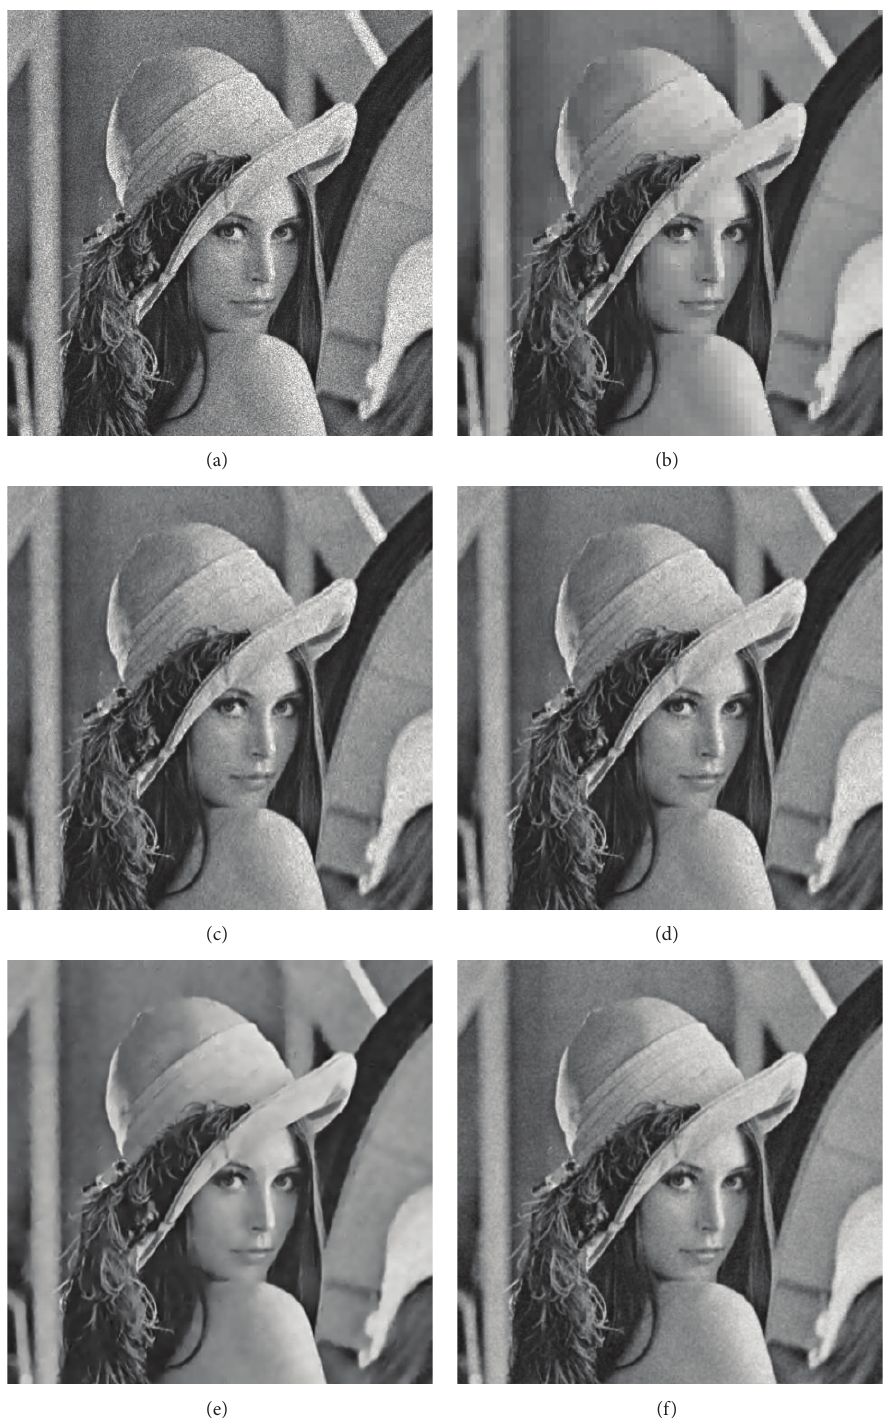
Figure 4: Comparison of the denoised images obtained from different denoising algorithms on test image Lena with 𝐿 = 12 . (a) Noisy image. (b) Denoised image using SureShrink. (c) Denoised image using BayesShrink. (d) Denoised image using BLS-GSM. (e) Denoised image using K-SVD. (f) Denoised image using the proposed